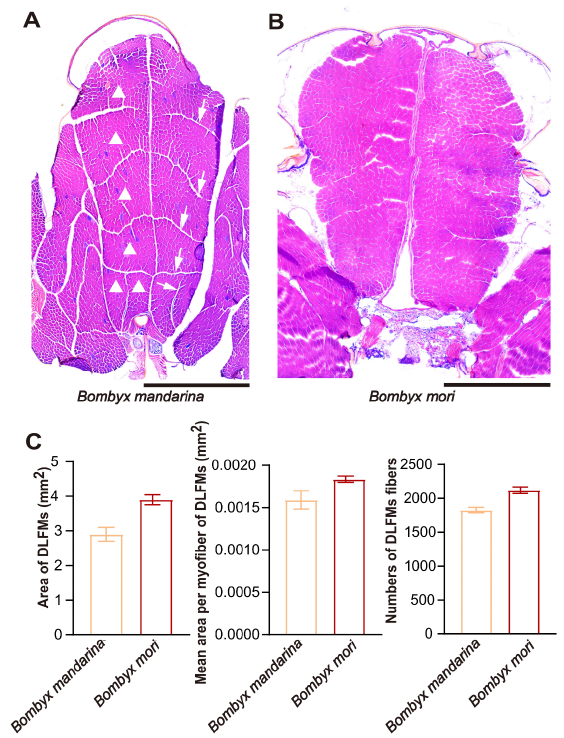
Figure 6. Light microscopy of dorsal longitudinal flight muscles (DFLMs) of silkmoths. ( A ) In B. mandarina , there were six DLFMs (triangles) separated by perimysia (arrows) on either side of the midline. All of the DLFMs can be seen in this section, bar = 1 mm. ( B ) In B. mori , the DLFMs in each side of the midline are not split into different parts, bar = 1 mm. ( C ) Area of DLFMs (mm 2 ), mean area per myofibers in DLFMs (mm 2 ) and the number of myofibers in DLFMs were quantified, mean ± SEM., n = 3, Student’s t -test, two-tailed, p area = 0.127, p mean area = 0.370, p number = 0.092.